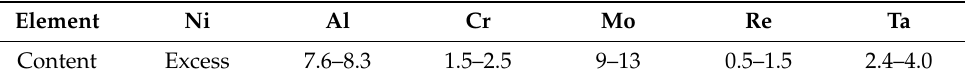
Table 1. Composition of the used Ni 3 Al–based single–crystal superalloy (mass %). Element Ni